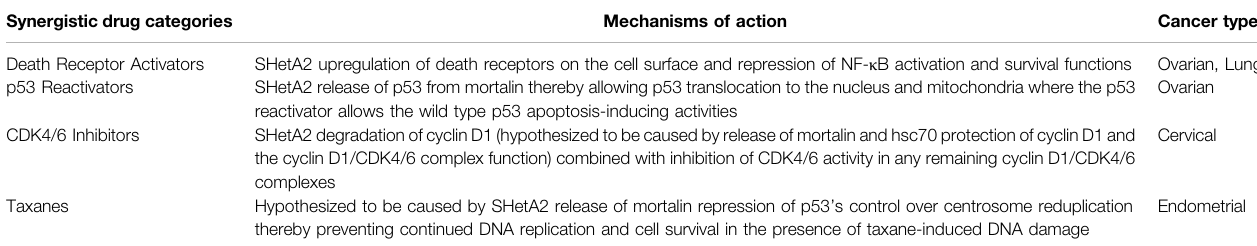
TABLE 2 | Mechanisms of SHetA2 synergy with cancer